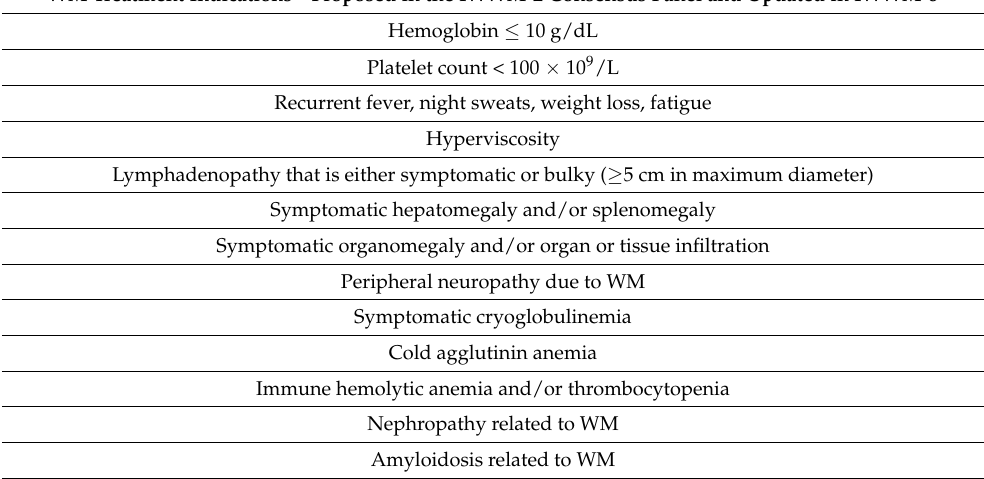
Table 1. WM consensus-based treatment